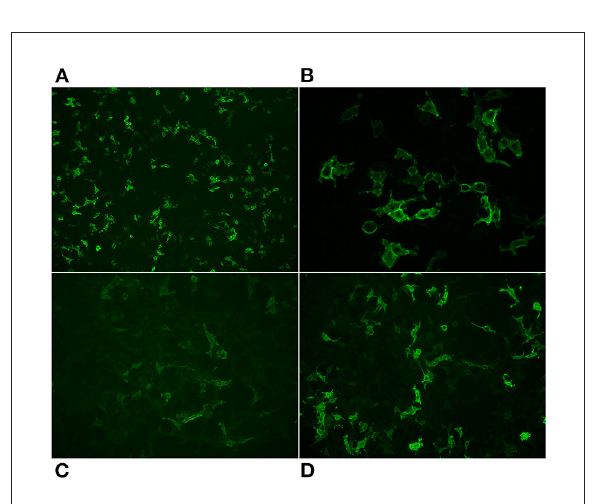
FIGURE2 Representative images of the reaction of antibodies from the patients’ serum with cells that express DPPX. Total IgG